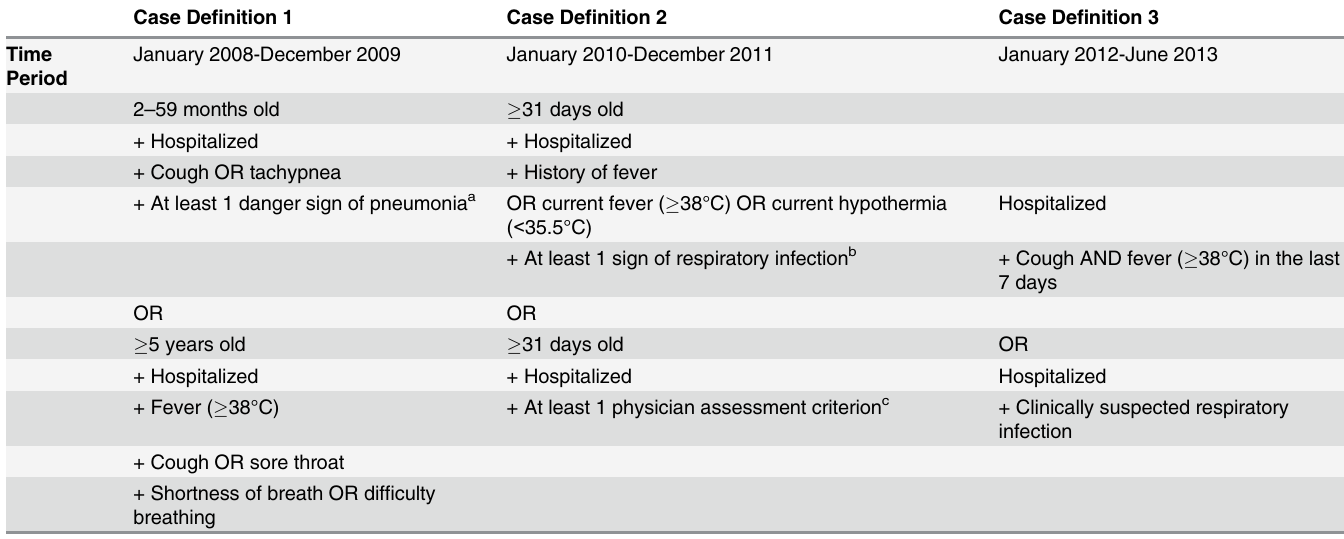
Table 1. Definition and time period of three severe acute respiratory infection (SARI) case definitions used in sentinel surveillance in Oman, Janu- ary 2008-June 2013. Case De fi nition 1 Case De fi nition 2 Case De fi nition